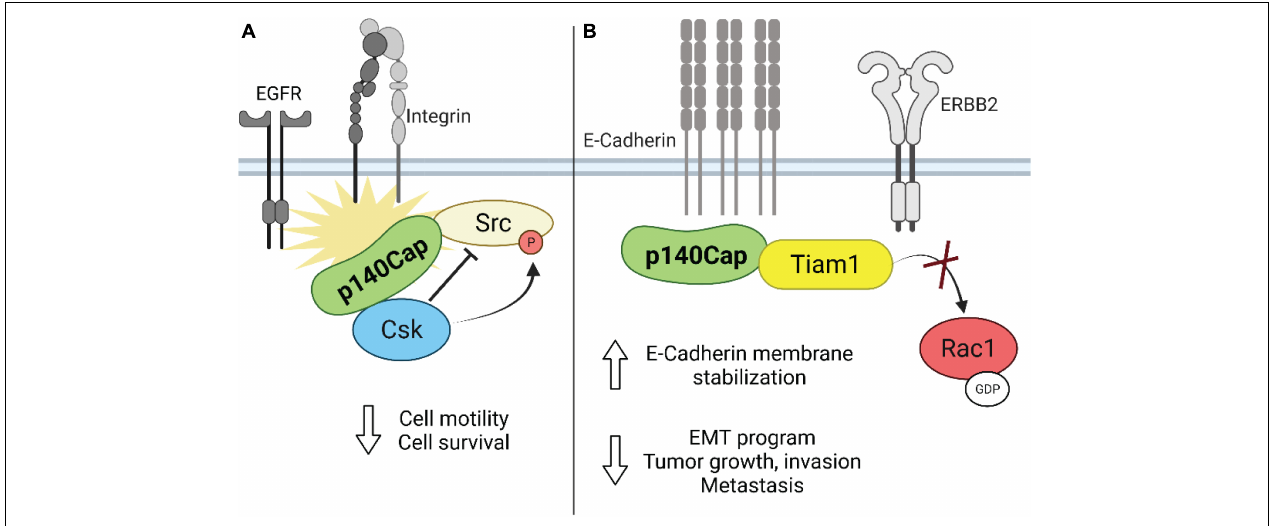
FIGURE 3 | Schematic representation of the role of p140Cap in breast cancer. (A) Upon integrin and growth factor-mediated signaling, p140Cap inhibits Src activity by binding to the Src inhibitor Csk. (B) p140Cap counteracts the EMT process by increasing E-cadherin stability at the plasma membrane in luminal A cell line MCF7. Moreover, p140Cap downregulates Rac1 activation by interfering with the Rac1-GEF Tiam in ERBB2 transformed cells.